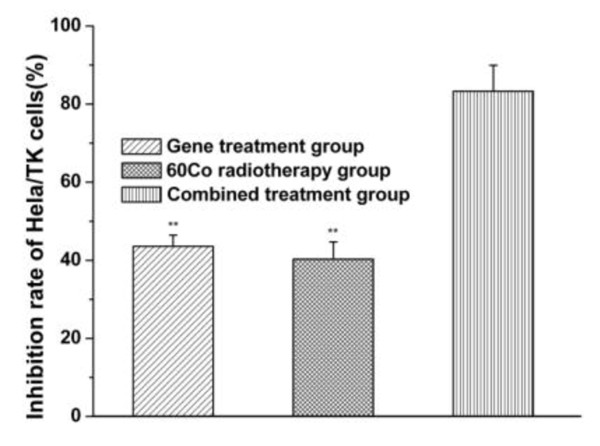
MTT experiments showed the inhibition rates of Hela/TK cell growth induced by different methods and the inhibition rates were 45.8 ± 7.3%, 42.4 ± 5.6% and 87.5 ± 10.32% respectively. Data were presented as the means ± SD of each experiments performed in triplicate. **P < 0.01 (gene treatment and 60Co radiotherapy group vs combined treatment groups) according to Student's t-test.